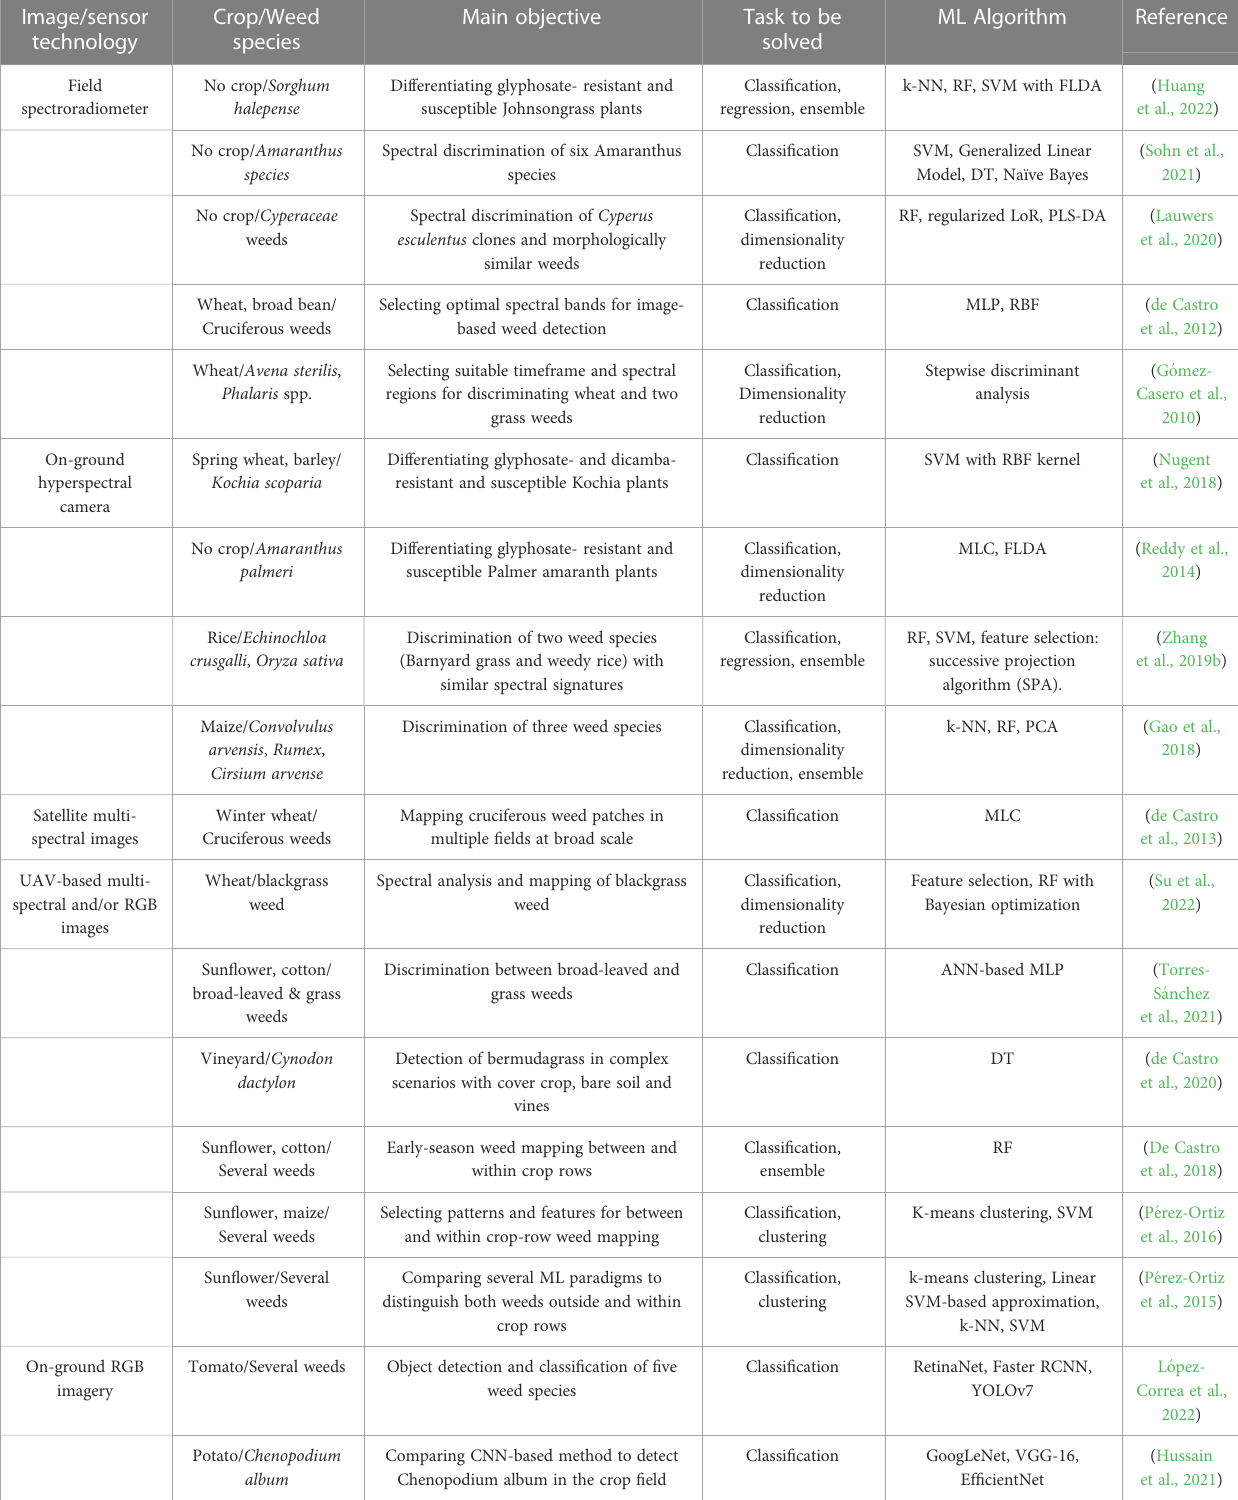
TABLE 4 Relevant investigations on ML algorithms in the domain of crop